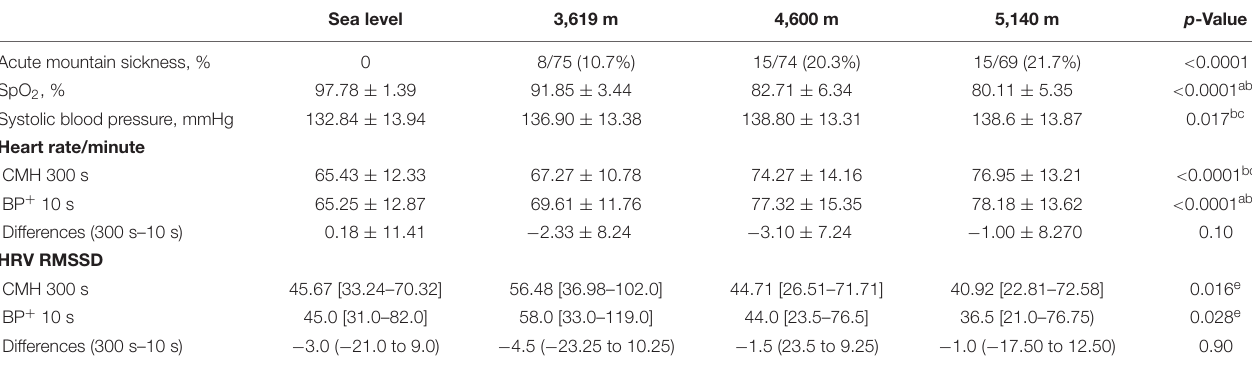
TABLE 2 | The effect of high-altitude on physiological variables and heart rate variability.